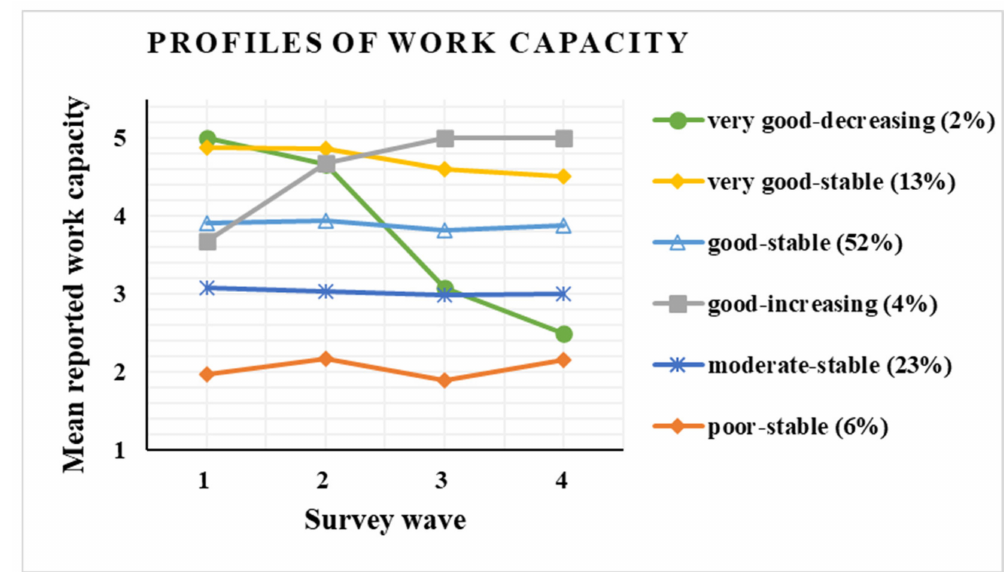
Figure 2. Profiles of work ability during COVID-19 lockdown among university employees (number of participants in each profile: high-decreasing = 12, high = 87, good = 375, good-increasing = 26, moderate = 157, poor = 39). T1–T4 are data collection points: T1, April 2020; T2, June 2020;